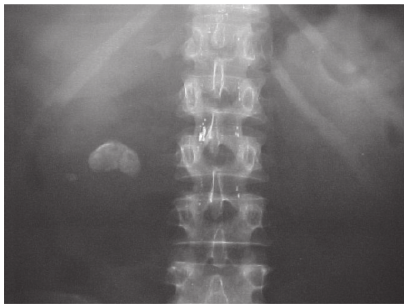
Figure 1 - Plain X-ray demonstrating arcuate-shaped calcification at right flank compatible with renal